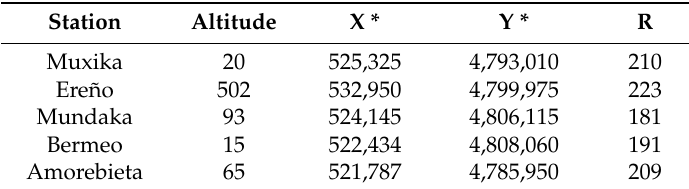
Table 1. Annual rainfall erosivity factor (R) for the five study rain gauge stations. Station Altitude X * Y